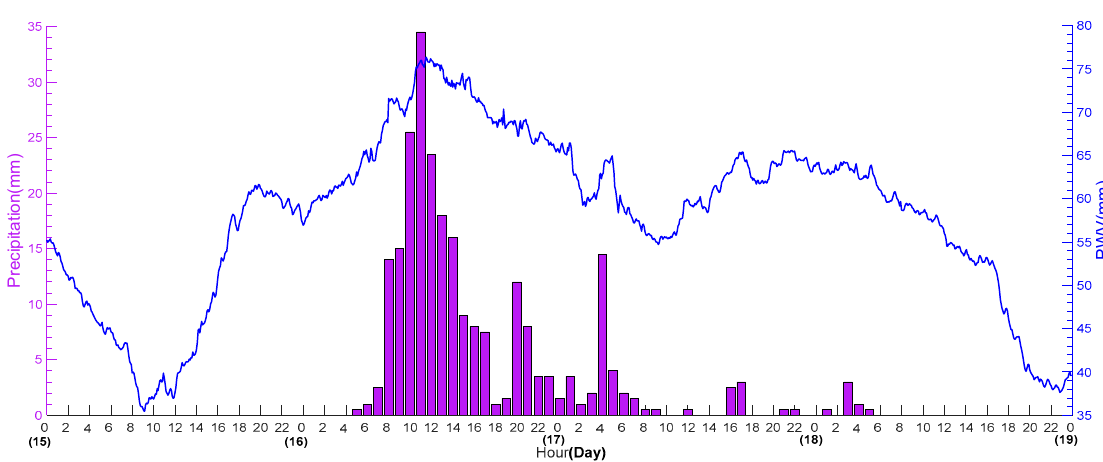
Figure 11. Times series of 3-min PWV (blue line) and hourly precipitation (purple histogram) over the HKLT station during the four-day period of 15–18 September.